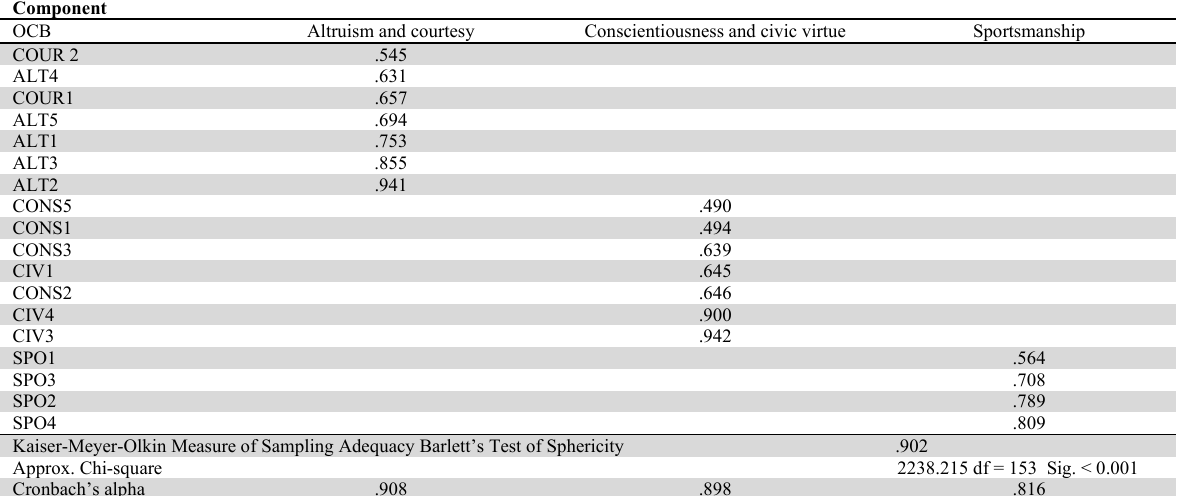
Exploratory Factor Analysis results of